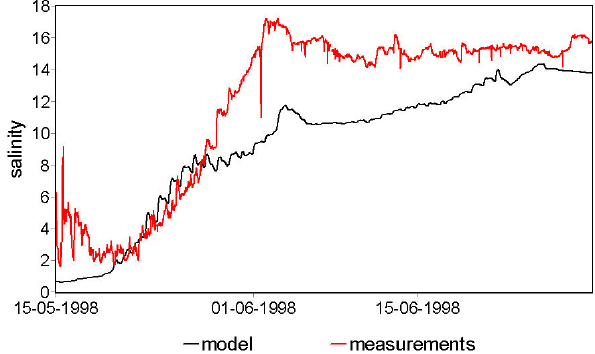
Fig. 3. Validation of the hydrodynamic model: presentation of the salinities measured in the field (red) versus the salinities generated by the model